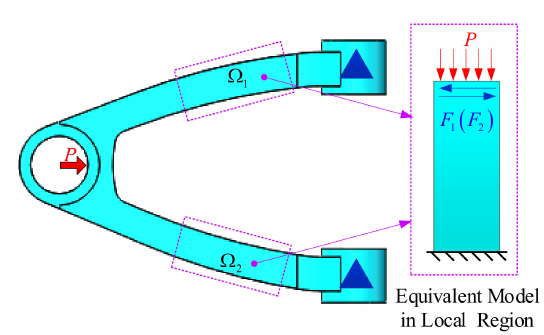
Figure 11. The load equivalent diagram on one side main-branch.